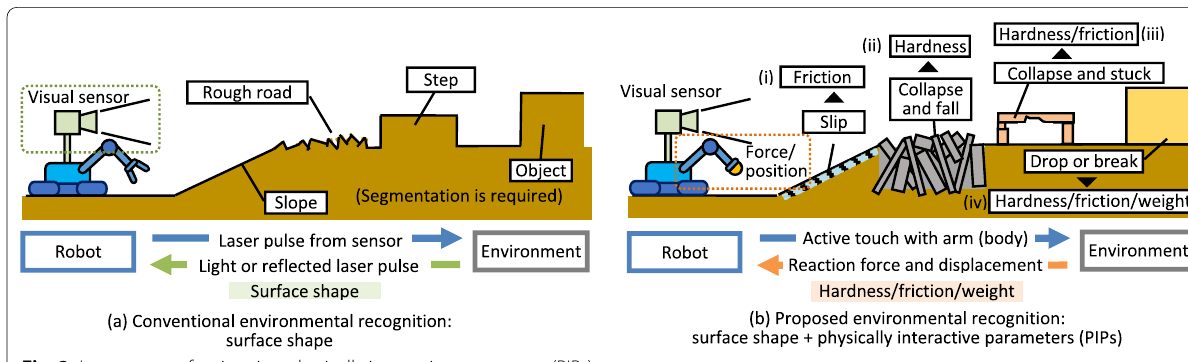
Fig. 2 Importance of estimating physically interactive parameters